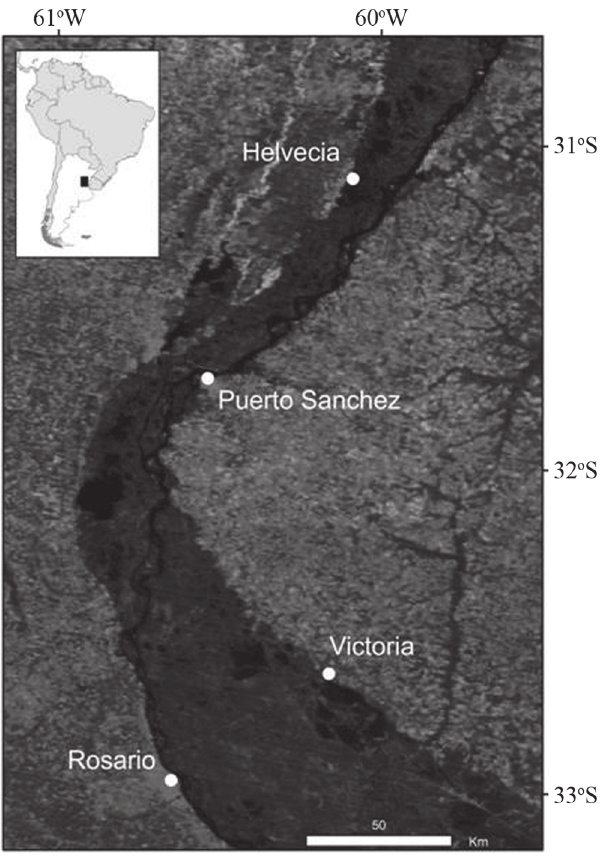
Fig. 1. Study area and the location of the main landing sites of the sábalo fisheries in the lower Paraná